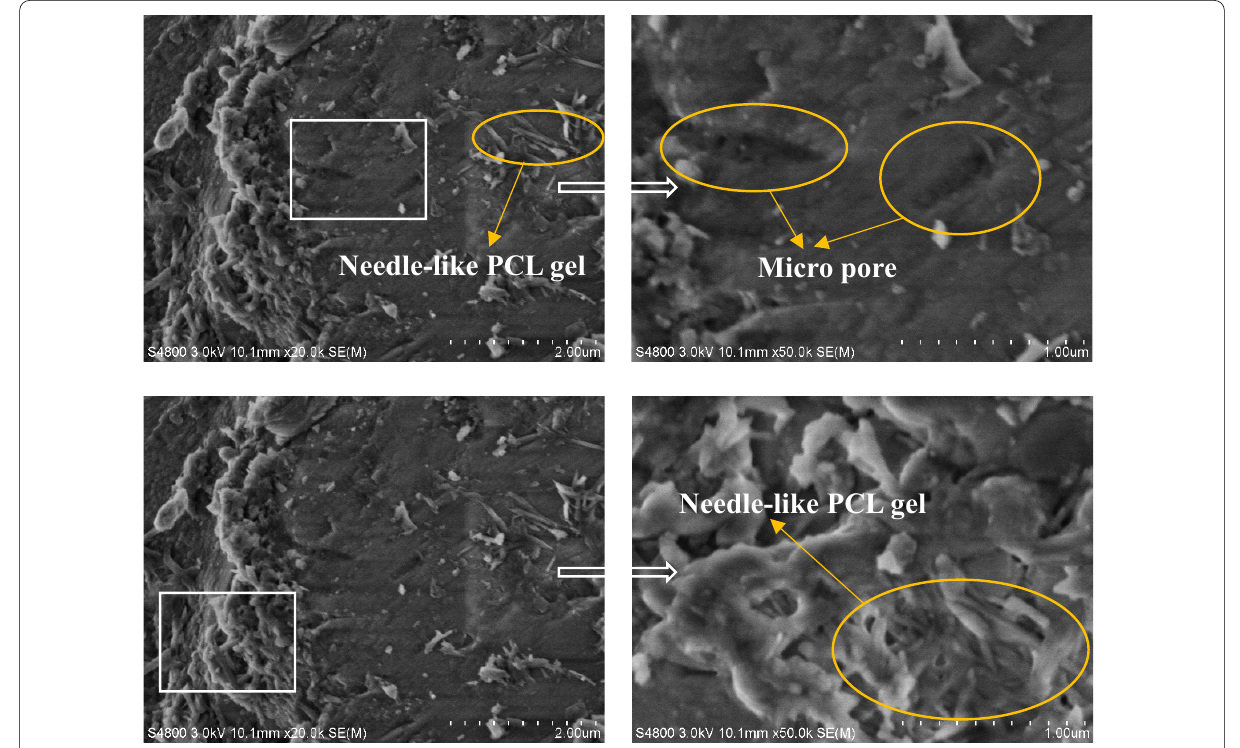
Fig. 20 SEM image of PCL‑cement mortar cross section (PCL